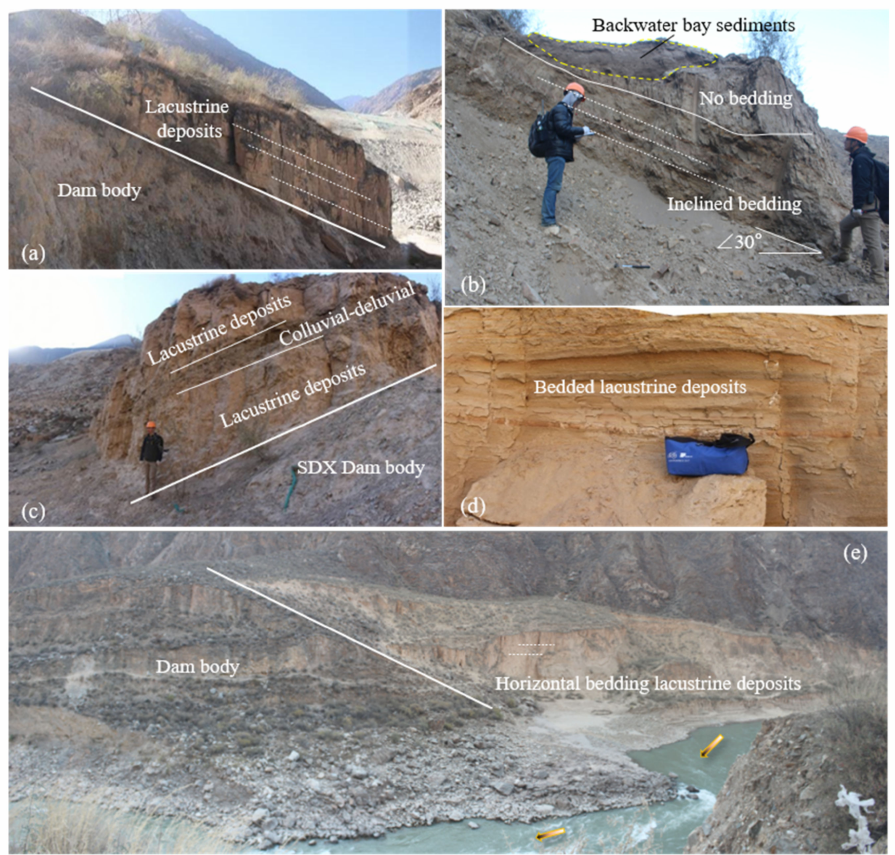
Figure 13. Typical geological phenomena. ( a ) Inclined lacustrine sedimentary layer on SDX dam body upstream. ( b ) Horizontal sedimentary layer covers inclined sedimentary layer phenomenon on GD dam body. ( c ) Inclined lacustrine sedimentary layer on SDX dam body downstream. ( d ) Horizontally stratified lacustrine sediments in WDLII-RCR section. ( e ) Horizontally bedding lacustrine deposits layer on RCR dam body